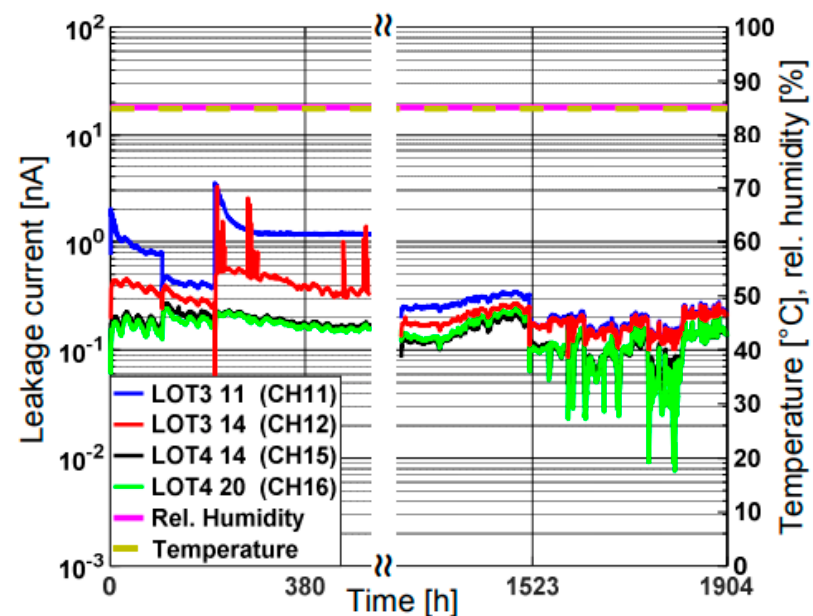
Figure 10. Leakage current monitoring during THB test on four 1200 V SiC-MOSFETS in plastic package. The right axis shows both temperature and relative humidity, having constant values throughout the whole duration of, respectively, T amb = 85 °C and R.H. = 85%. Current reading is so low that it is mostly determined by noise and offset correction. Figure reproduced with permission from [2].